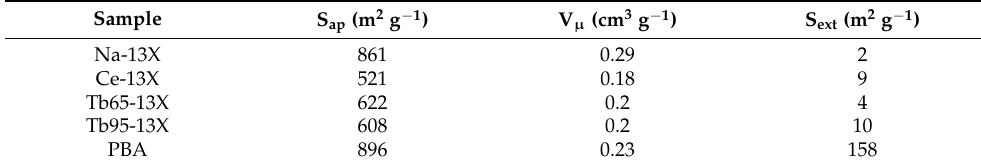
Table 1. Equivalent specific surface area (S ap ), micropore volume (V µ ), and external surface area (S ext ) for the samples studied in the present work, as obtained on the basis of the N 2 adsorption at 77 K after an overnight vacuum pre-treatment at 423